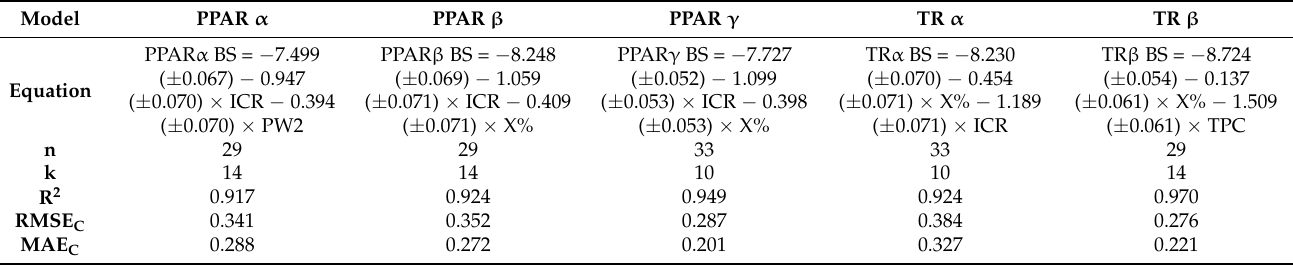
Table 1. Statistical parameters of to PPAR α , PPAR β , PPAR γ , TR α , and TR β